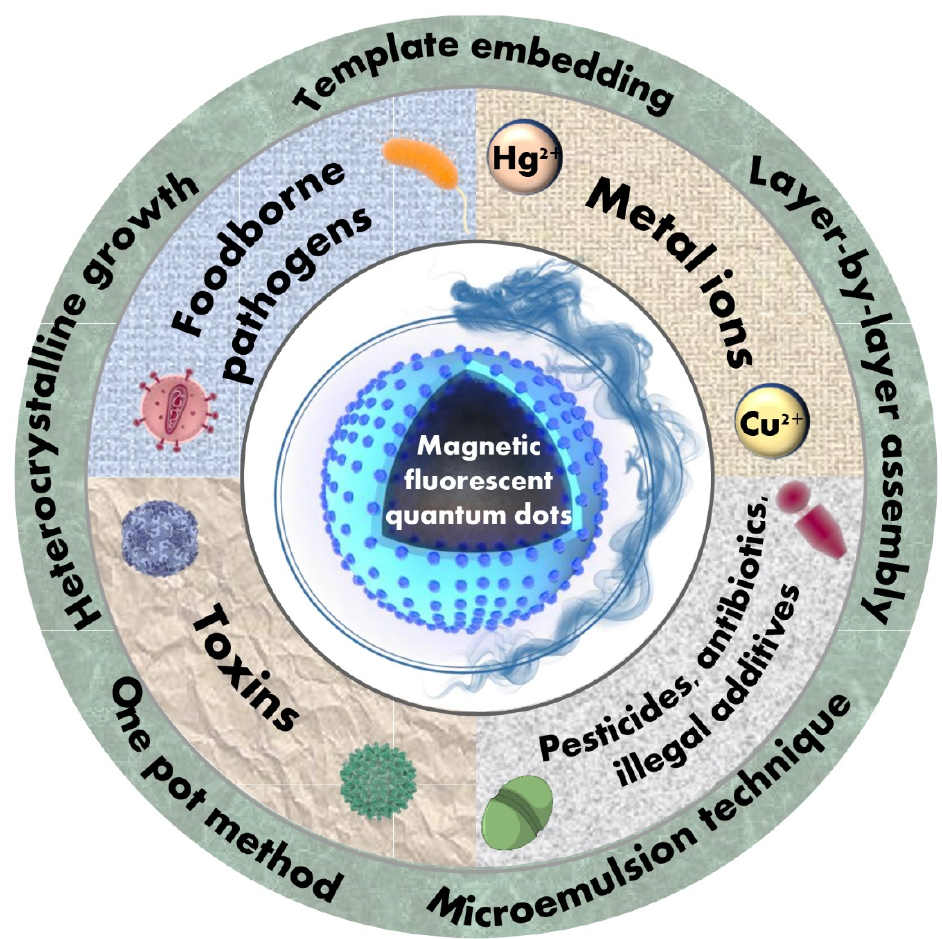
Figure 2. Overview of magnetic fluorescent quantum dots-based sensors for food contaminants analysis.